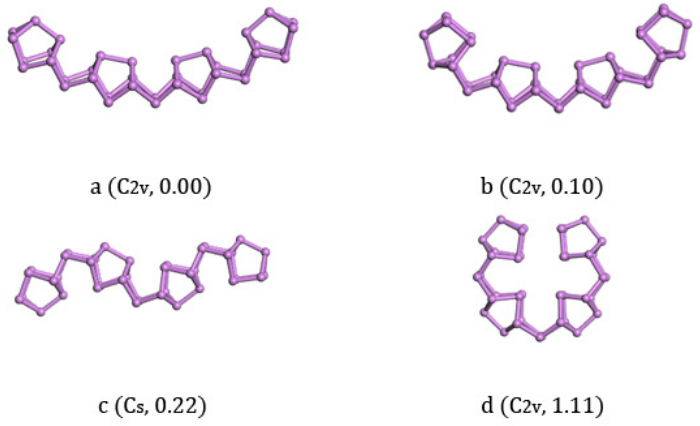
Figure 5. Lowest-energy and isomorphic structures for As 38 clusters. The relative total energies are in eV.